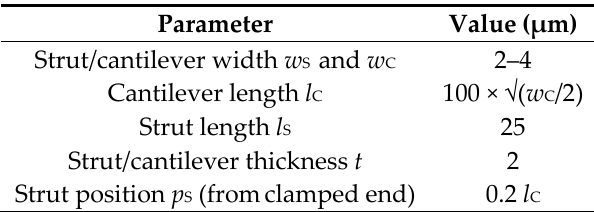
Table 1. Optimized cantilever dimensions and strut position.